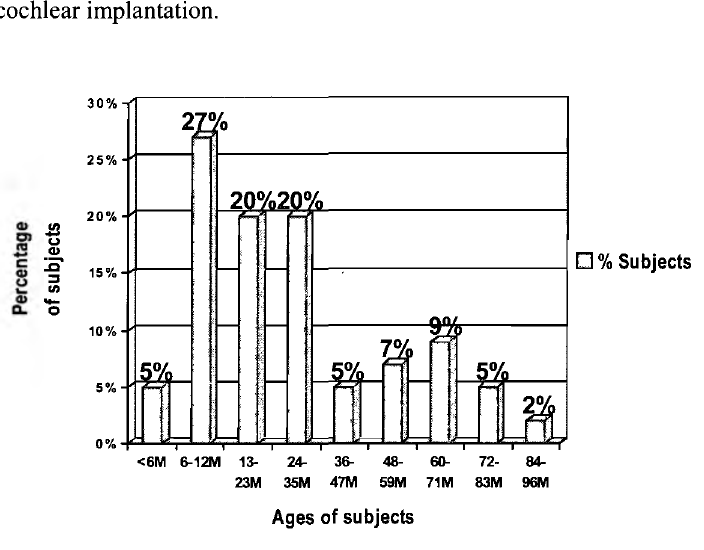
Figure 2: Period for which children wore hearing aids prior to cochlear